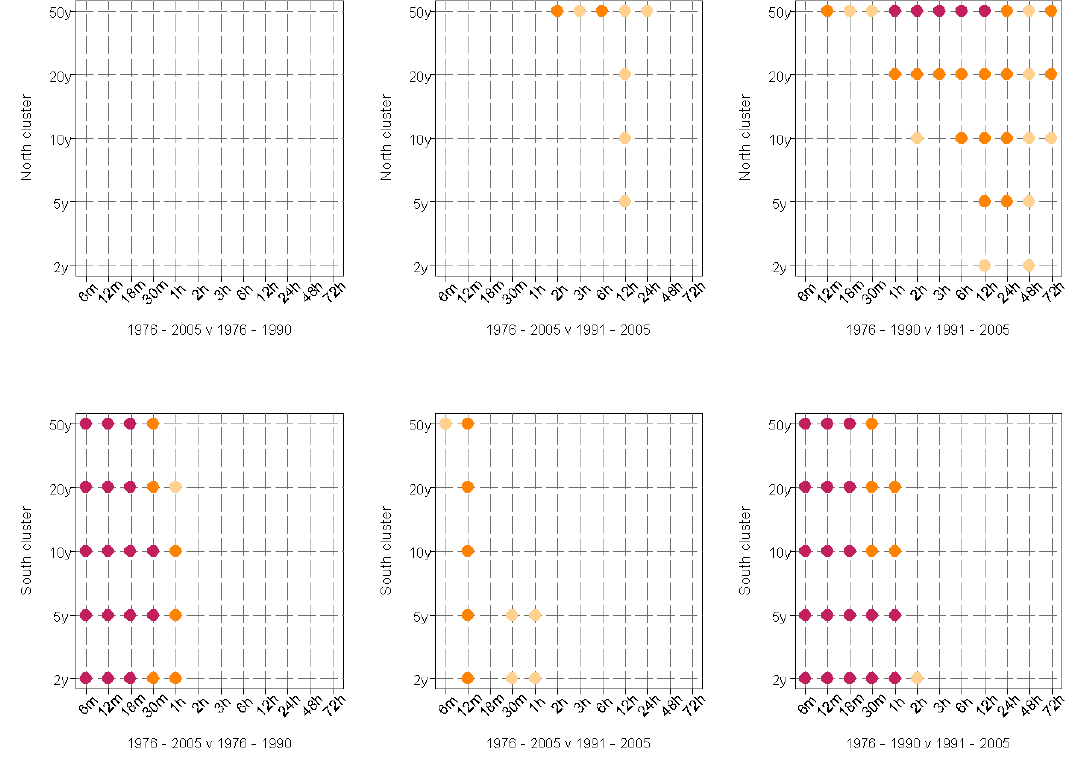
Fig. 6. Significance of difference in quantile estimates from regional analysis based on POT3 series for 12 durations (x-axis) and 5 return periods (y-axis). The top row shows the results for the modified north cluster (8 sites), bottom row for the south cluster (10